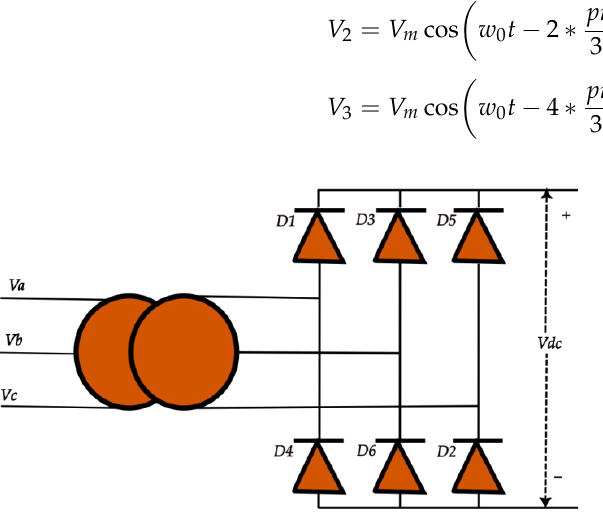
Figure 3. Three-phase bridge